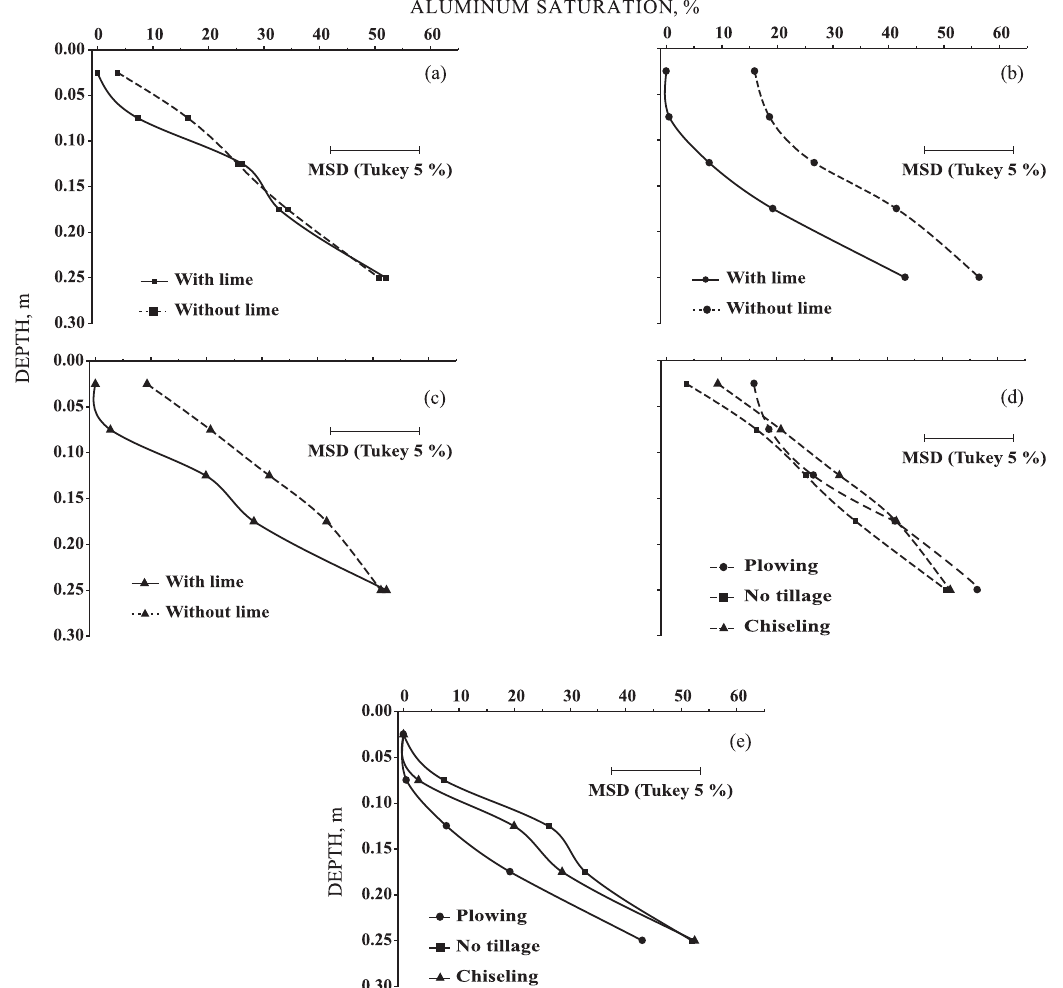
Figure 2. Values of aluminum saturation in an Oxisol under the no-till system, submitted to the modes of tillage: no tillage (a), plowing (b), chiseling (c) and liming: without lime (d) and with lime (e). MSD (minimum significant